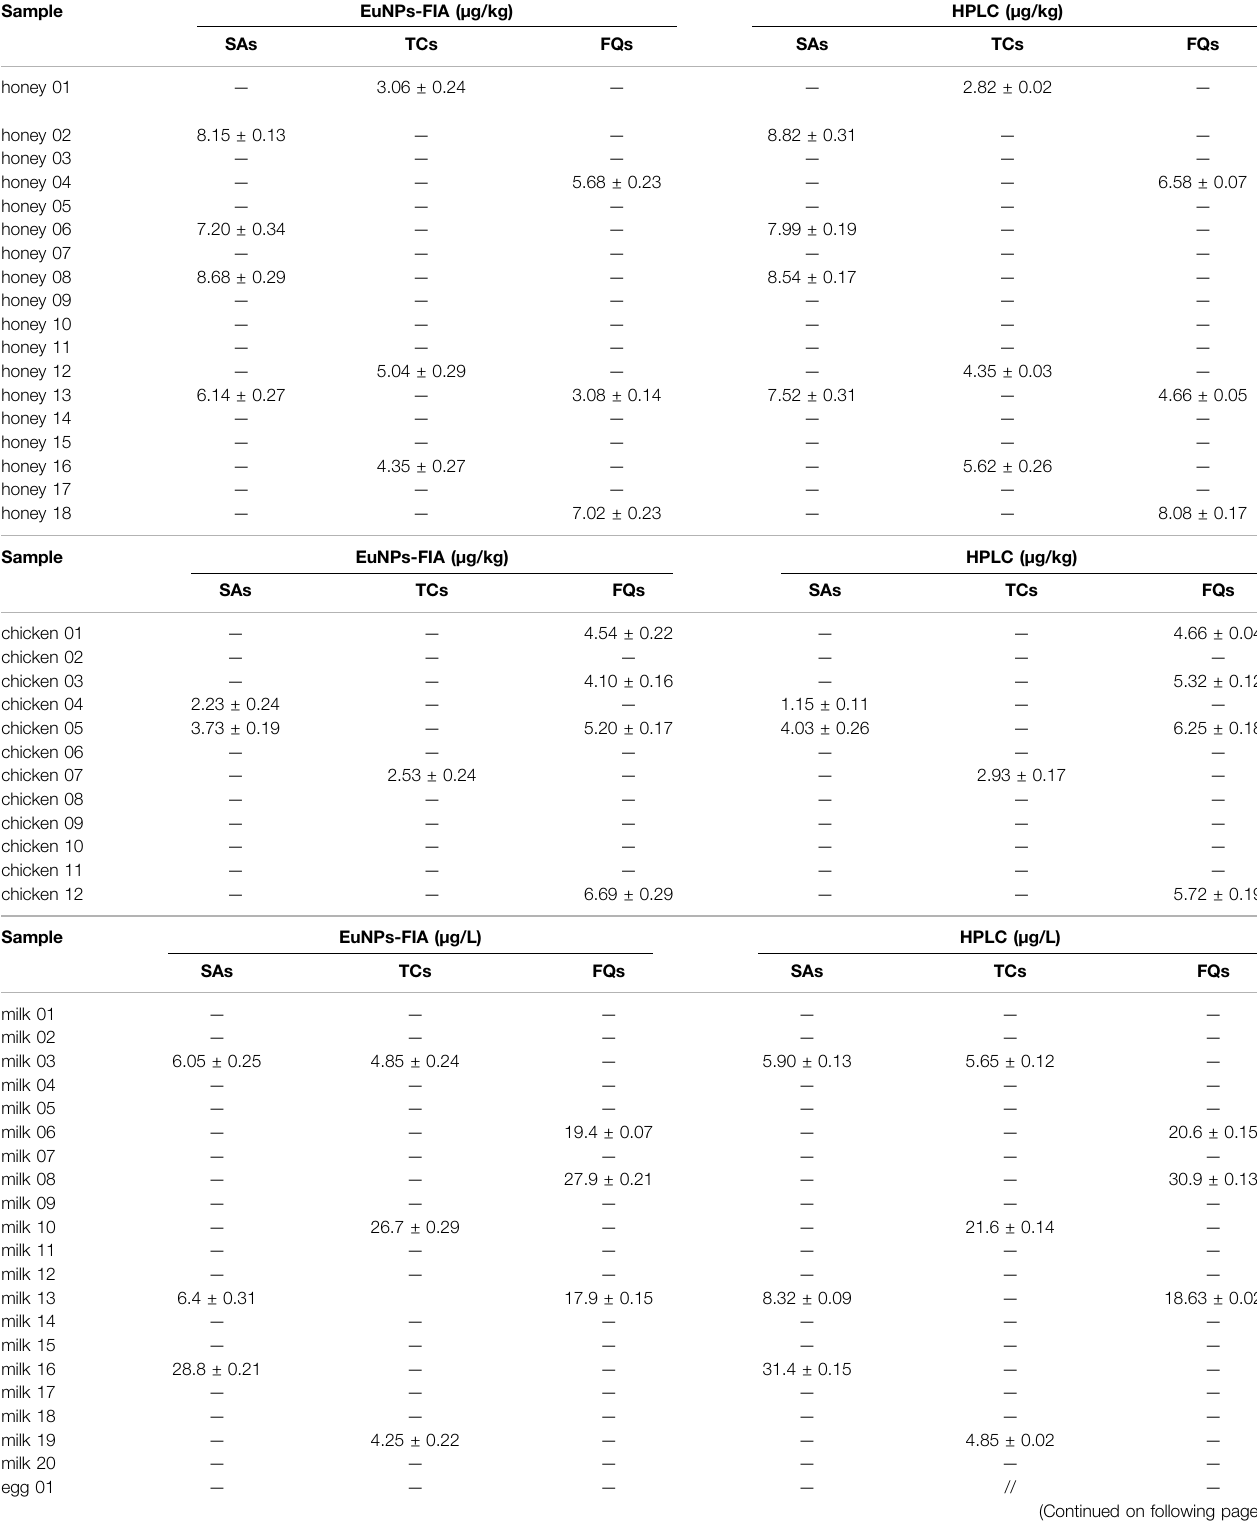
TABLE 5 | Detection of SAs, TCs and FQs in egg, milk, chicken and honey samples by three-multiple-EuNPs-FIA and HPLC. Sample